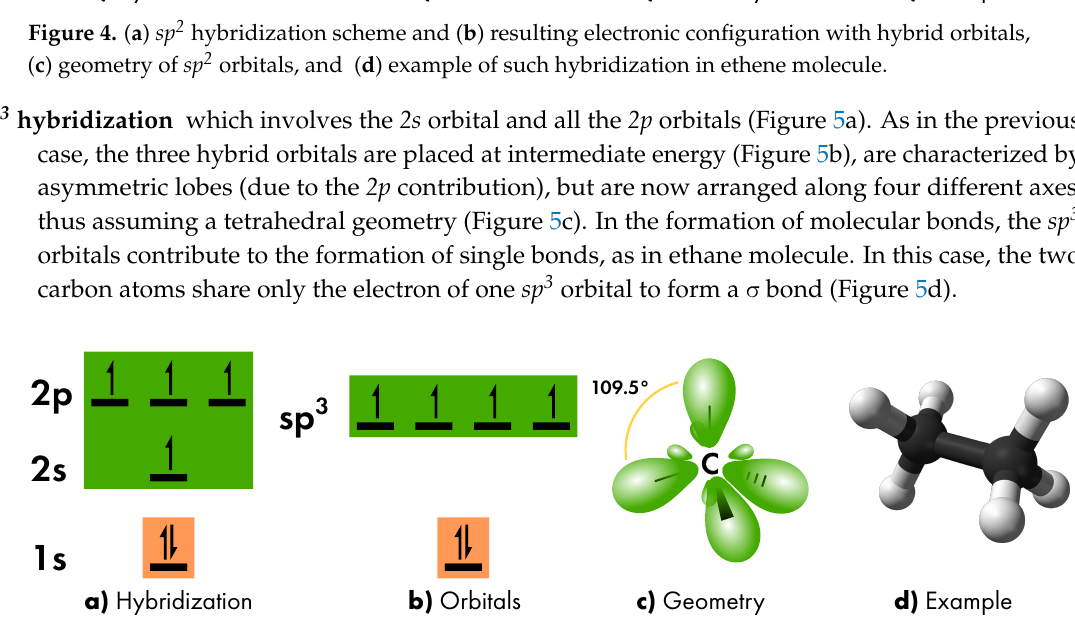
Figure 5. ( a ) sp 3 hybridization scheme and ( b ) resulting electronic configuration with hybrid orbitals, ( c ) geometry of sp 3 orbitals, and ( d ) example of such hybridization in ethane